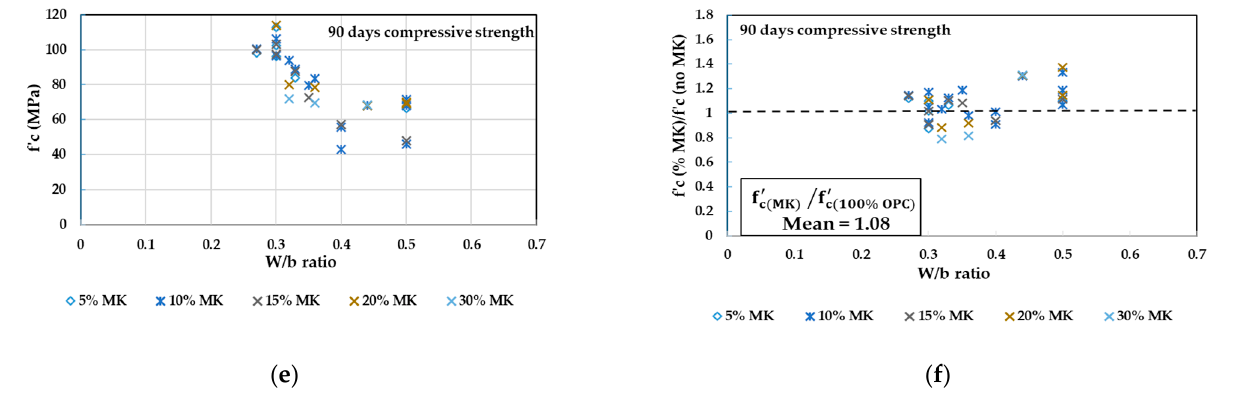
Figure 5. Concrete with Metakaolin (MK) as a partially replacing material for cement. Compressive strength vs. W/b ratio at ( a ) 7 days; ( c ) 28 days; ( e ) 90 days. Ratio between compressive strength of concrete with MK to concrete without MK at ( b ) 7 days; ( d ) 28 days; ( f ) 90 days.